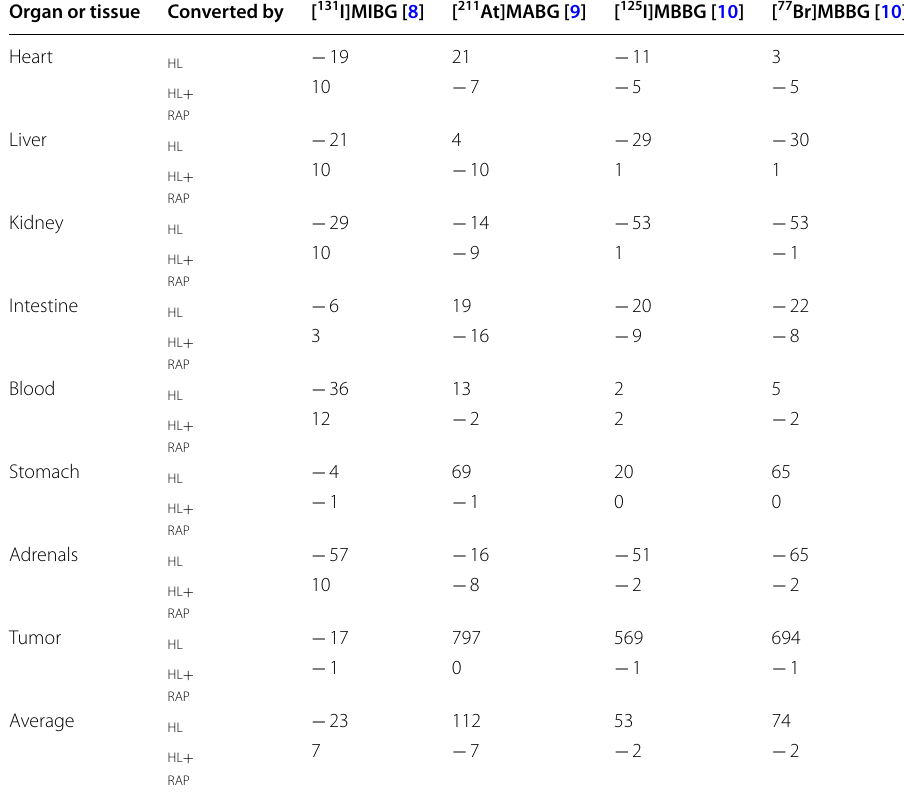
Table 1 Percent differences between converted absorbed doses and [ 211 At]MABG [8] absorbed dose Organ or tissue Converted by